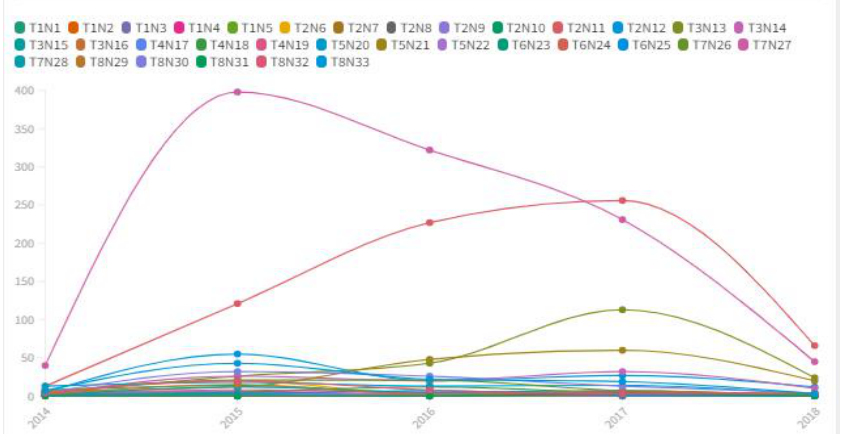
Figure 2: Narratives about the Coverage of the Crimean Conflict by Sputnik and RT and how they have changed from 2014 to 2018 (Source: Authors‟ depiction based on the registry of publications on the websites of both